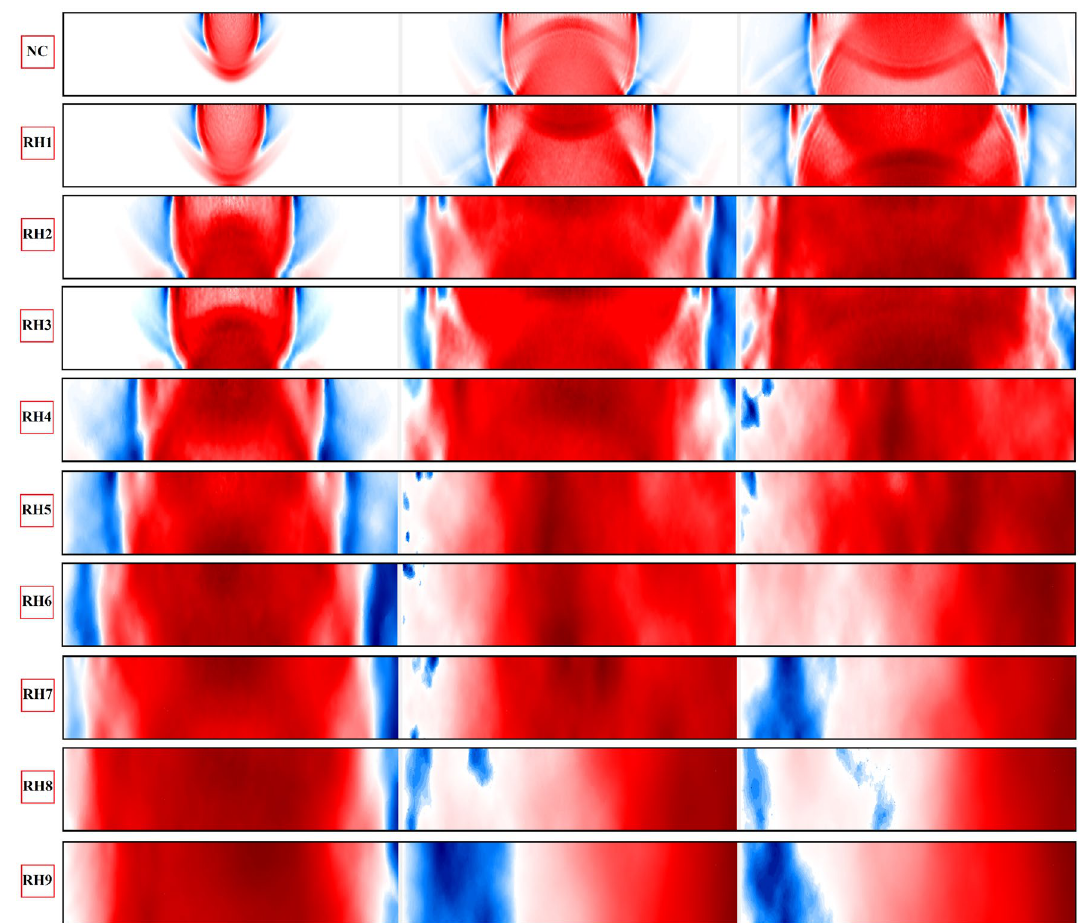
5 10 (s)) and different − ×